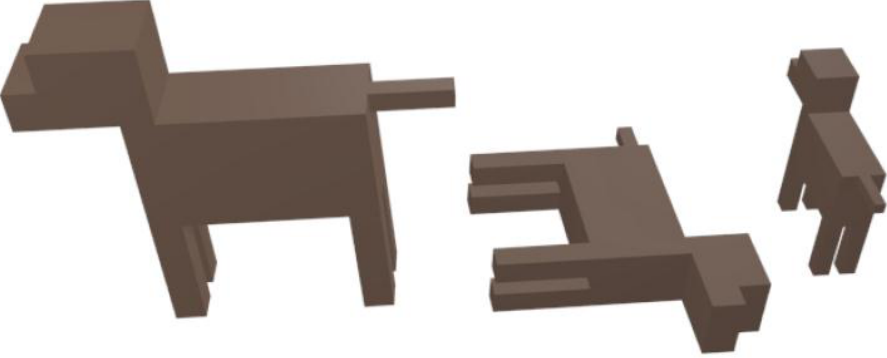
Figure 3. Example of the simplified dog model in different position and with different sizes.